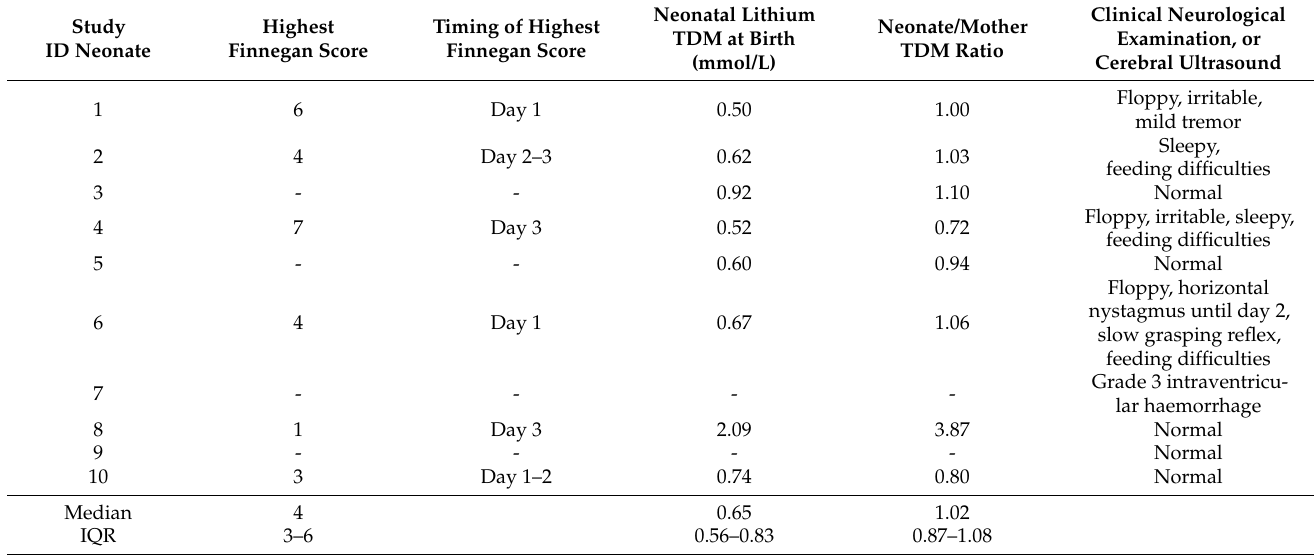
Table 5. Neurological assessment and lithium neonate/mother therapeutic drug monitoring (TDM) ratio.